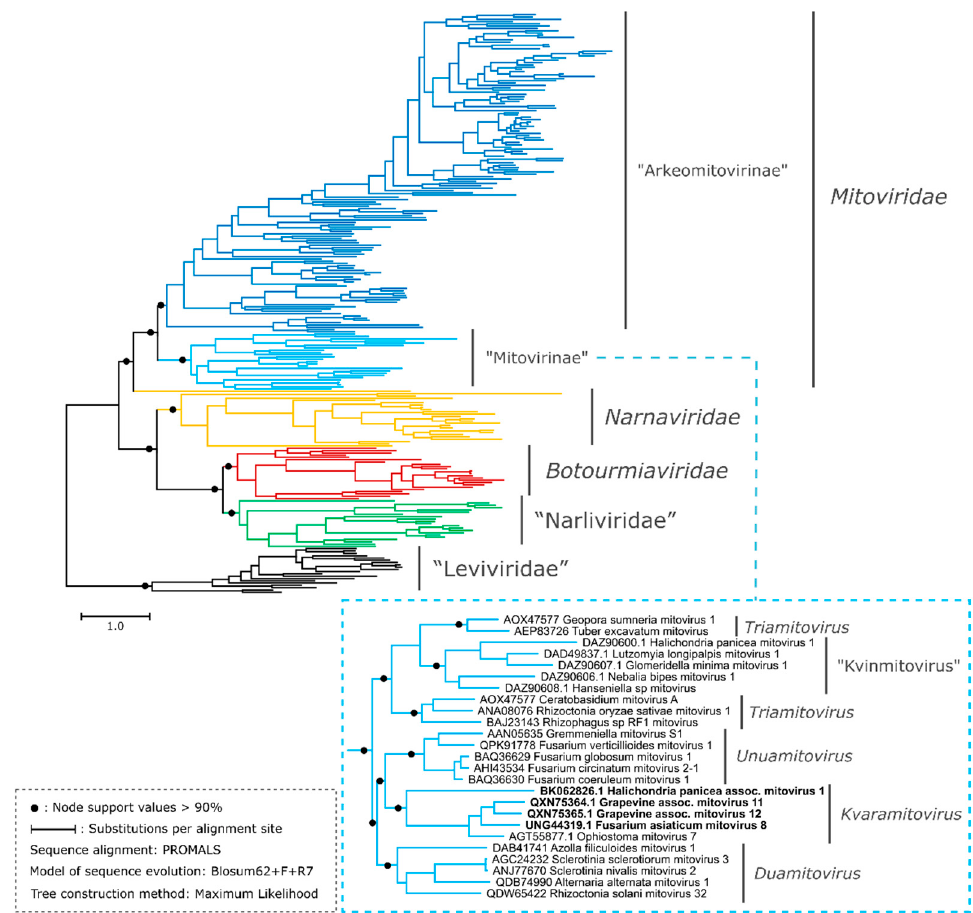
Figure 2. Generalized midpoint-rooted tree of 254 RdRp aa sequences encoded by representative members of the phylum Lenarviricota . Branches color-code: blue indicates the proposed subfamily “Arkeomitovirinae” (“Clade B”), cyan indicates formal mitoviruses fitted to the proposed subfamily “Mitovirinae” (formal genera Unuamitovirus, Duamitovirus, Triamitovirus and Kvaramitovirus , and also the proposed genus “Kvinmitovirus”). The family Mitoviridae comprises members of the blue and cyan branches. Orange, red and green indicate the families Narnaviridae , Botourmiaviridae and “Narliviridae”. New members proposed for the genus Kvaramitovirus (“Clade A”) are indicated in bold type in the sub-tree corresponding to the proposed “Mitovirinae” subfamily. The supplementary Figure S2 shows the tree displayed with the labels of the 254 members and the values of the nodes. The phylogenetic reconstructions are detailed in the Materials and Methods section.